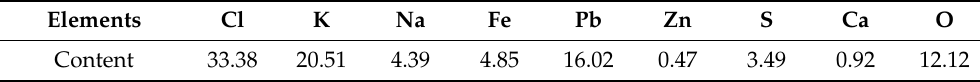
Table 1. Main elements in iron ore sintering dust (mass fraction, %).